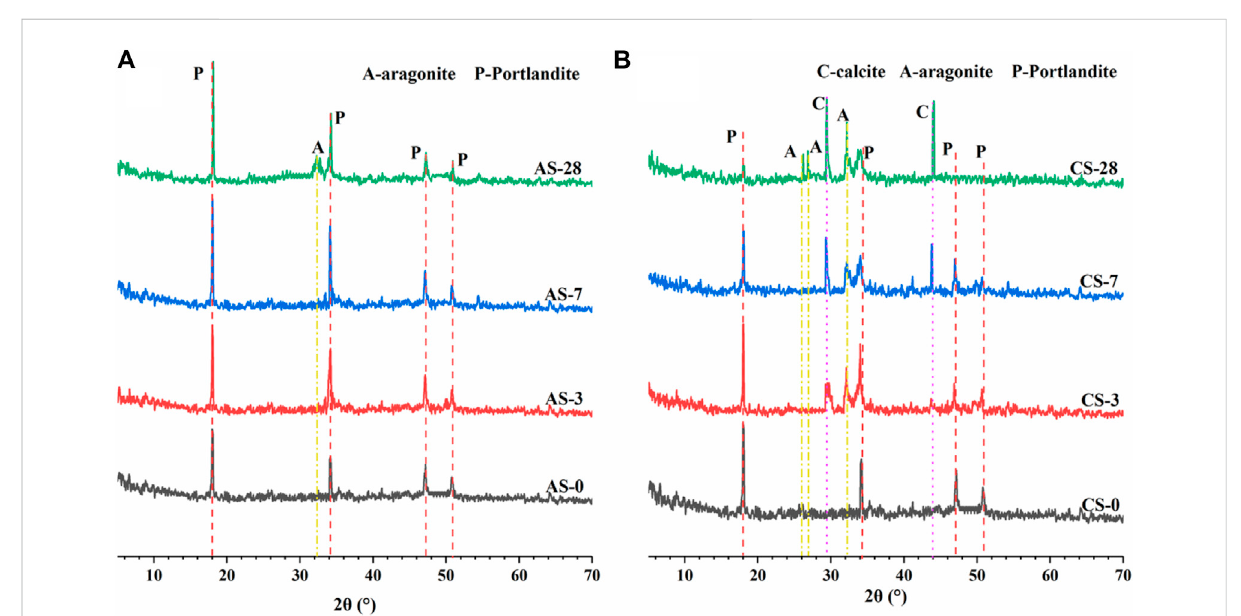
FIGURE 2 XRD analysis results for the self-healing product in the surface cracks of the (A) control and (B) self-healing